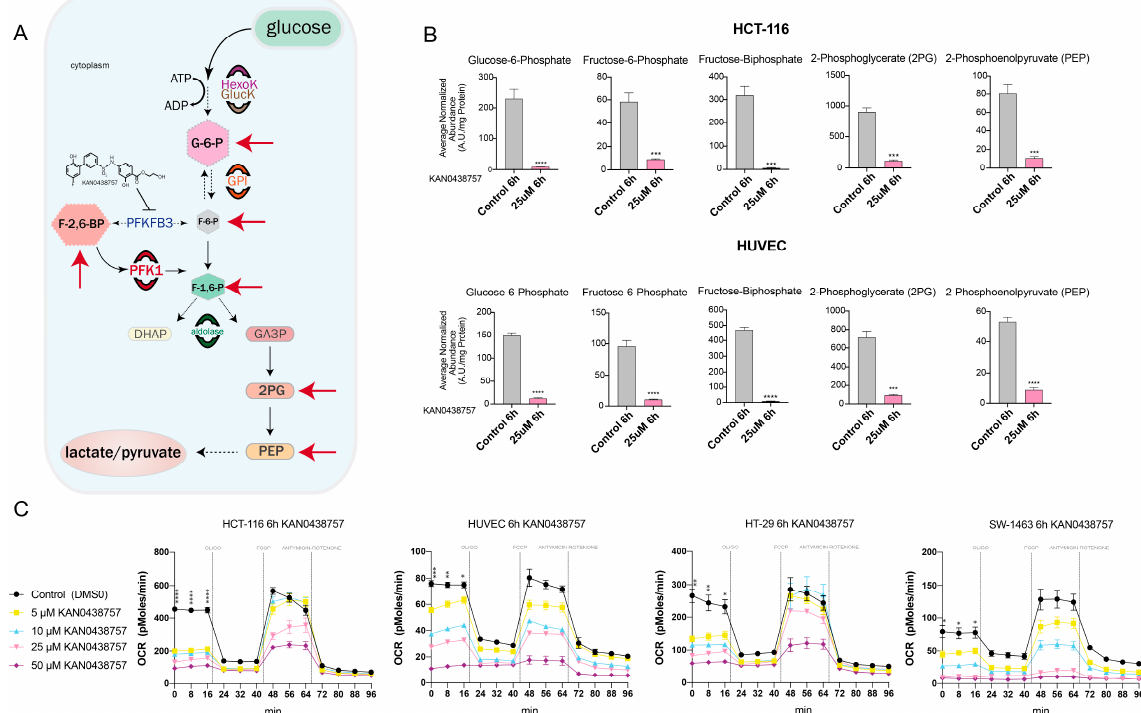
Figure 3. KAN0438757 effectively reduces glycolytic metabolites’ levels. ( A ) Glycolysis schematic representation. Red arrows mark the metabolites directly affected by KAN0438757 treatment in vitro. ( B ) LC-MS metabolomic analysis for HCT-116 cancer cells and HUVECs after 6h treatment with KAN0438757. ( C ) Seahorse analysis for oxygen consumption rate (OCR) evaluation performed with colorectal cancer cells and HUVECS upon 6 h treatment with KAN0438757. ( C ) Data is representative of three independent experiments. Data is ± SEM. * p < 0.05, ** p < 0.01 *** p < 0.001, **** p <